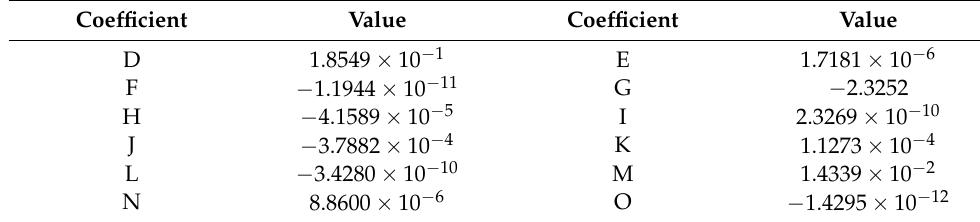
Table 2. Coefficients for the C l quadratic Re number model.